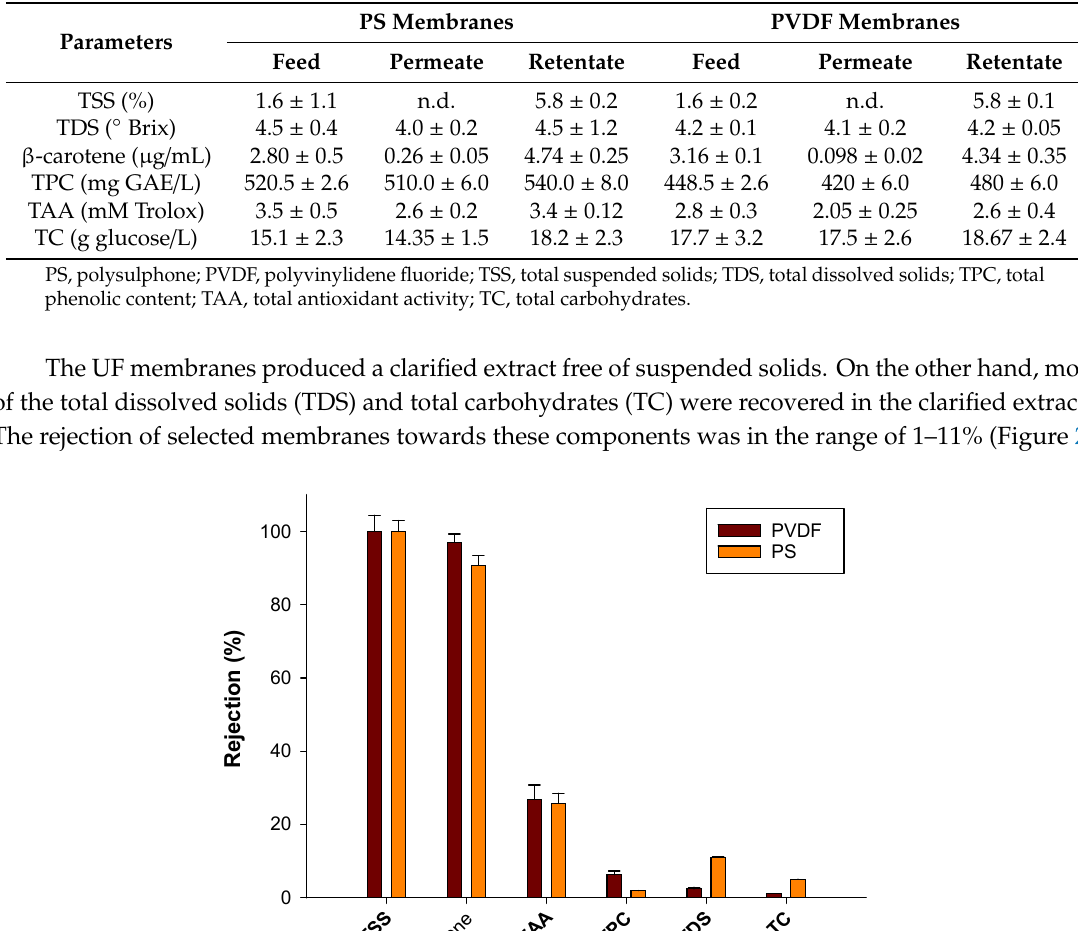
Table 1. Chemical composition of Goji berry extract clarified by hollow fiber membranes.